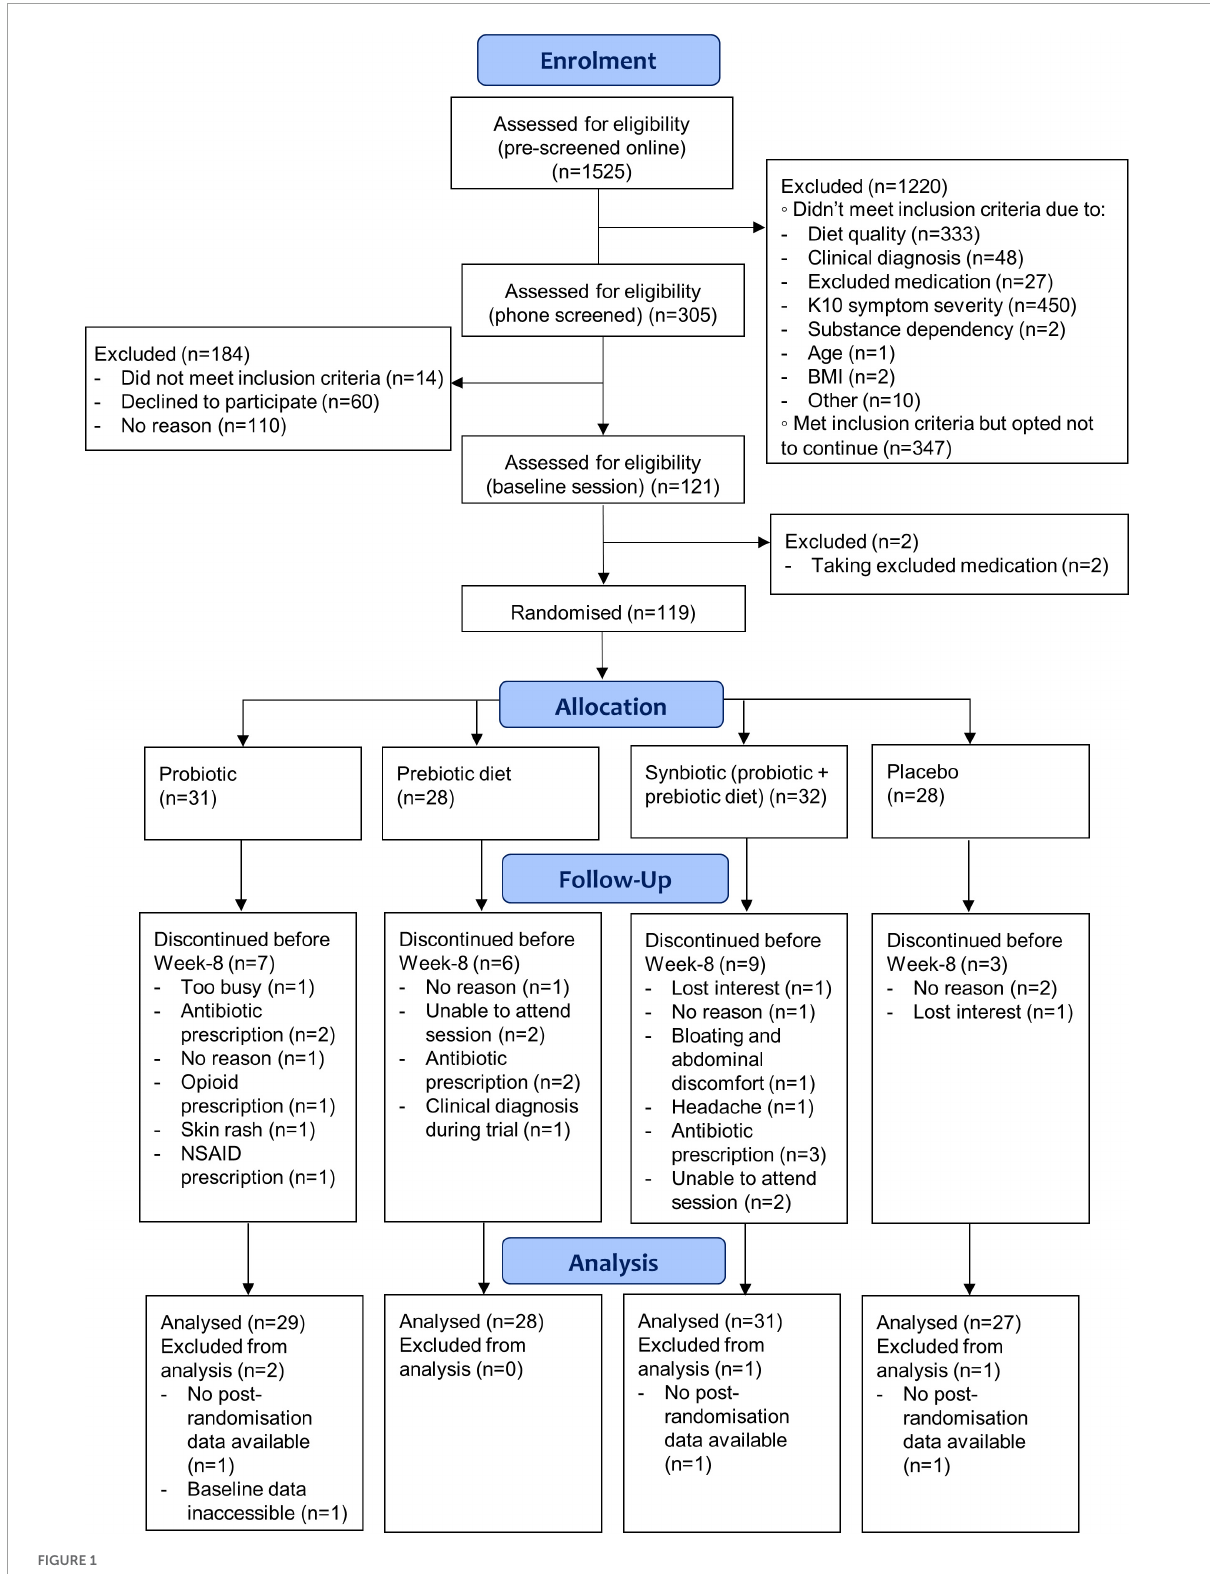
FIGURE1 CONSORT flow